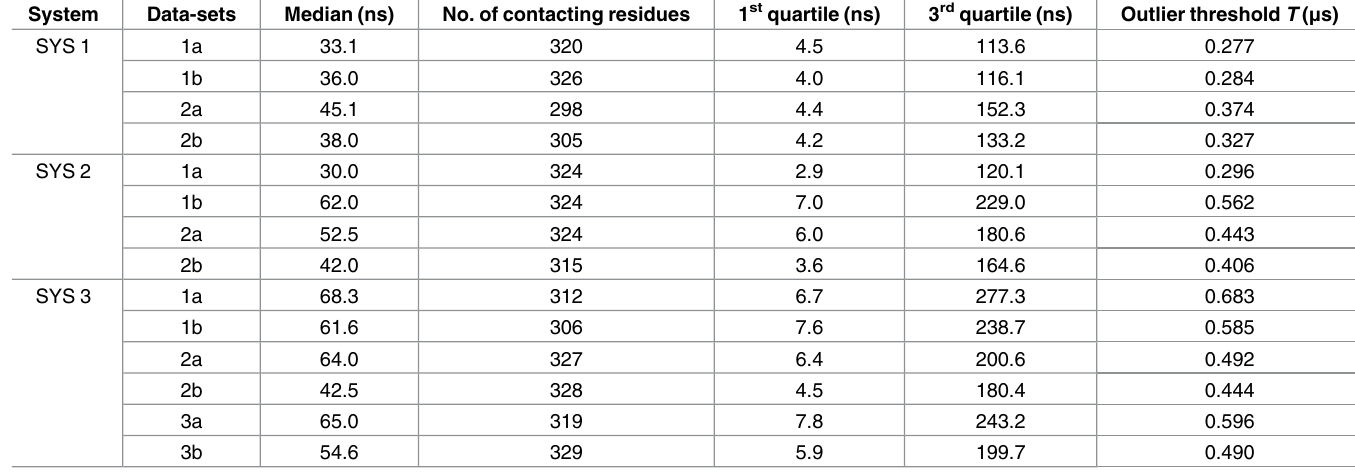
Table 1. Data spread of t max distributions obtained from all monomers within SYS1-3, including SYS3.3. System